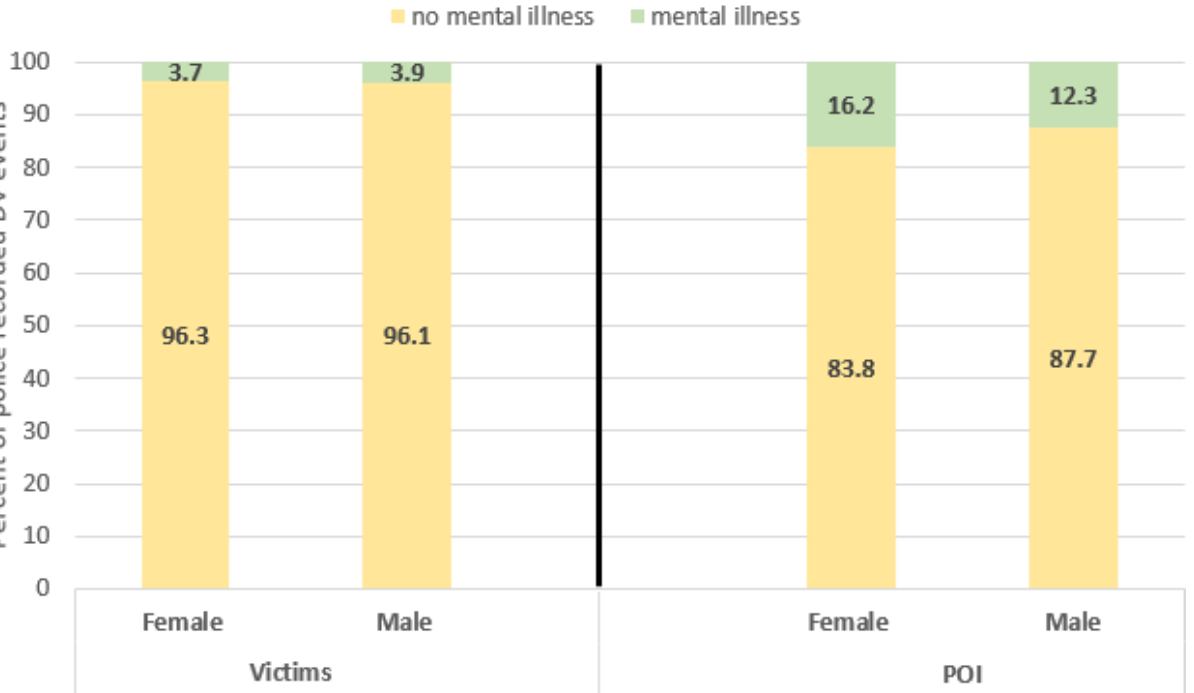
Figure 1. Proportion of police-recorded DV events with mental illness by sex of victims and